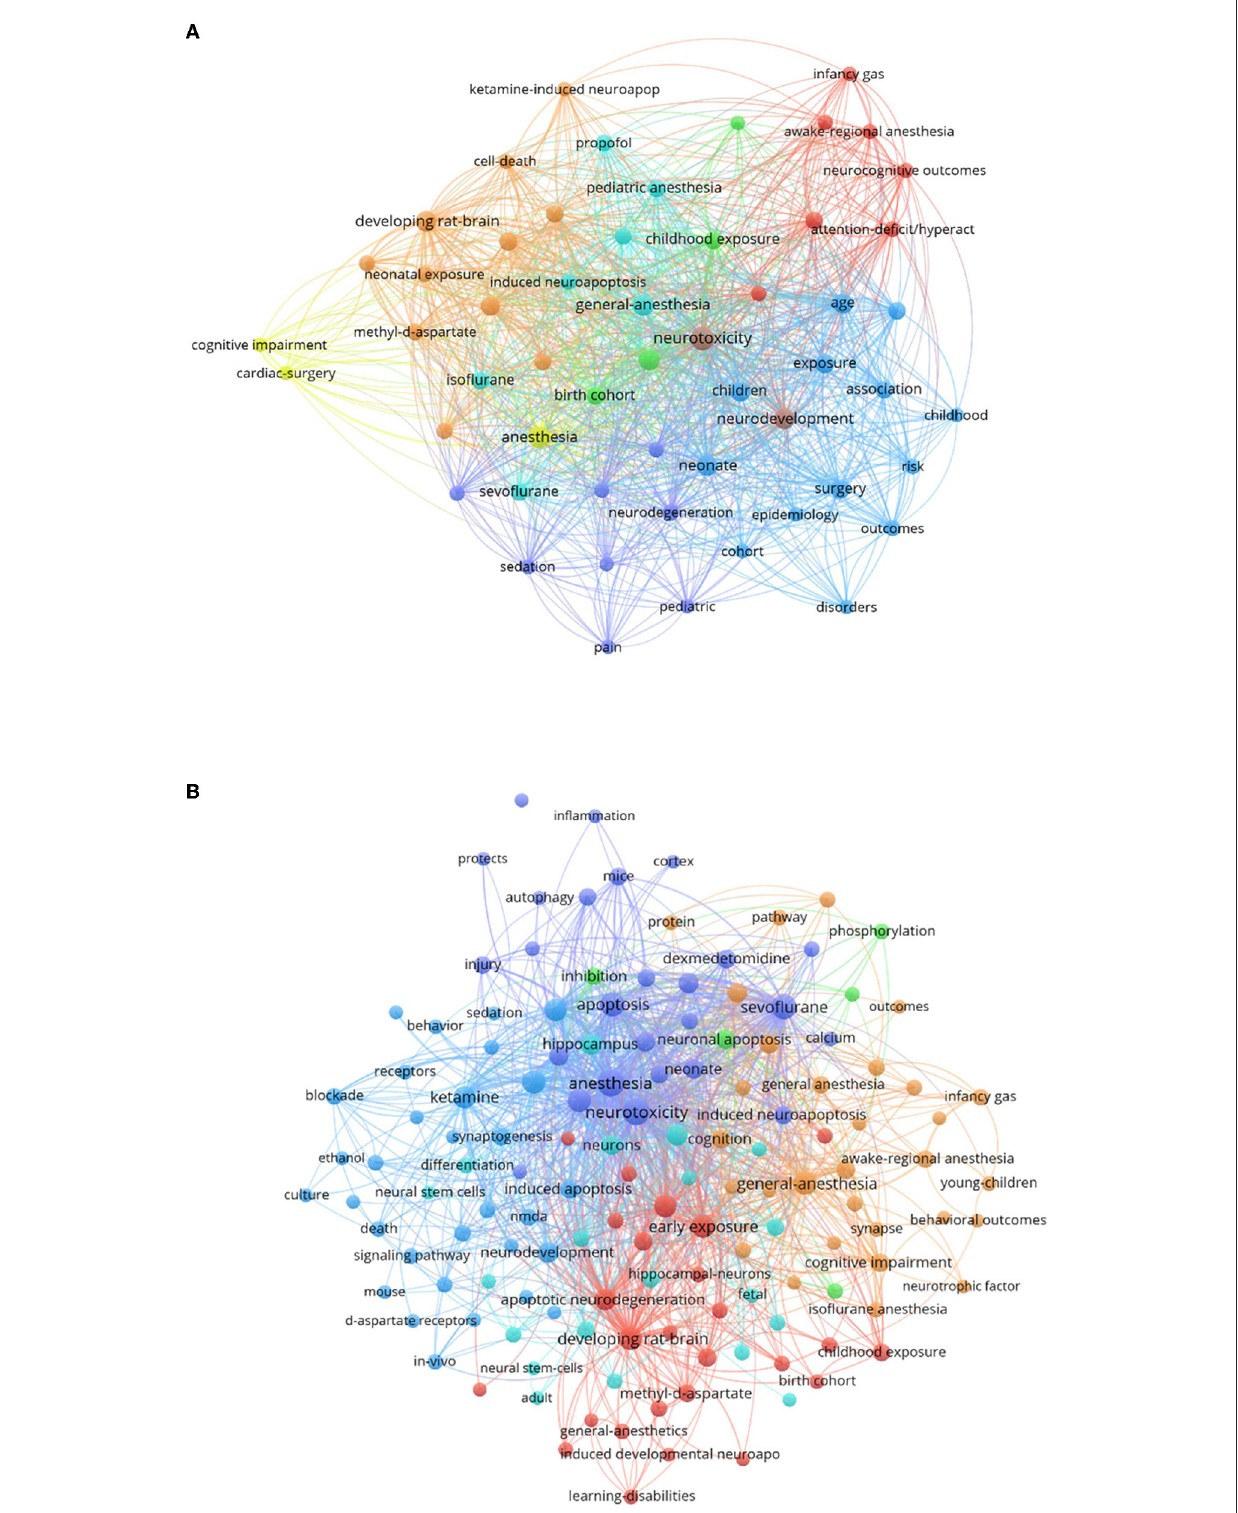
FIGURE7 A summary of the hotspot trends of articles on the neurotoxicity of anesthesia in the developing brain. The diameter of the circles and the thickness of the lines show how frequently certain keywords occur together. (A) Clinical research hotspots of articles published on the neurotoxicity of anesthesia in the developing brain. (B) Basic research hotspots of articles published on the neurotoxicity of anesthesia in the developing